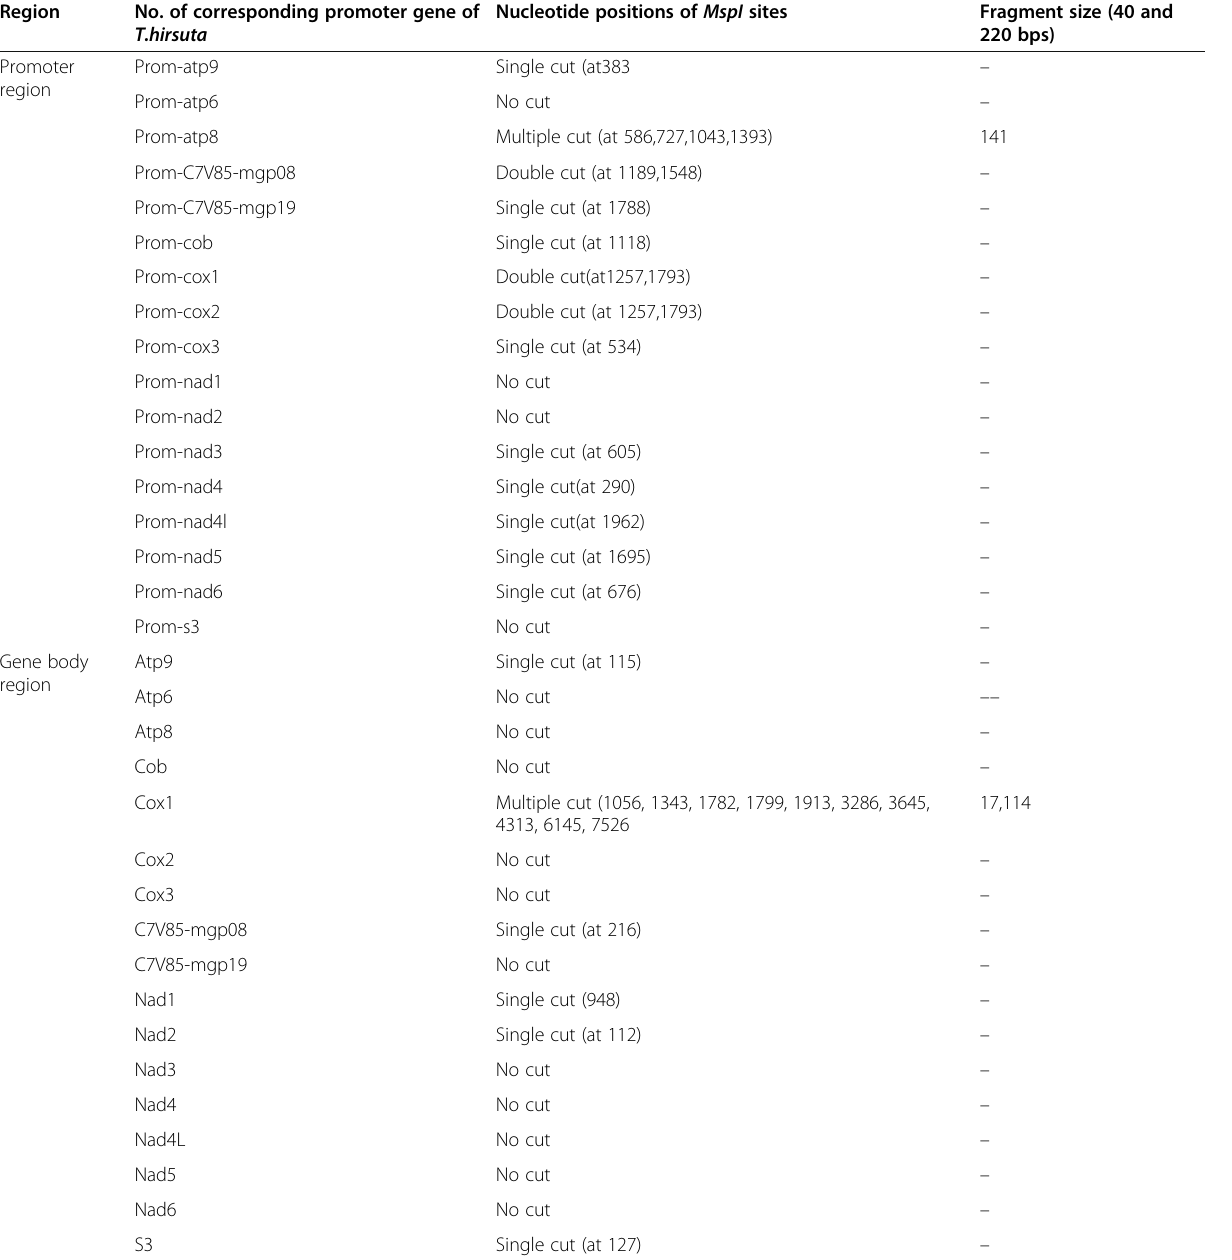
Table 5 Determination of MspI cutting sites and fragment sizes for Trametes hirsuta strain 072 promoter regions